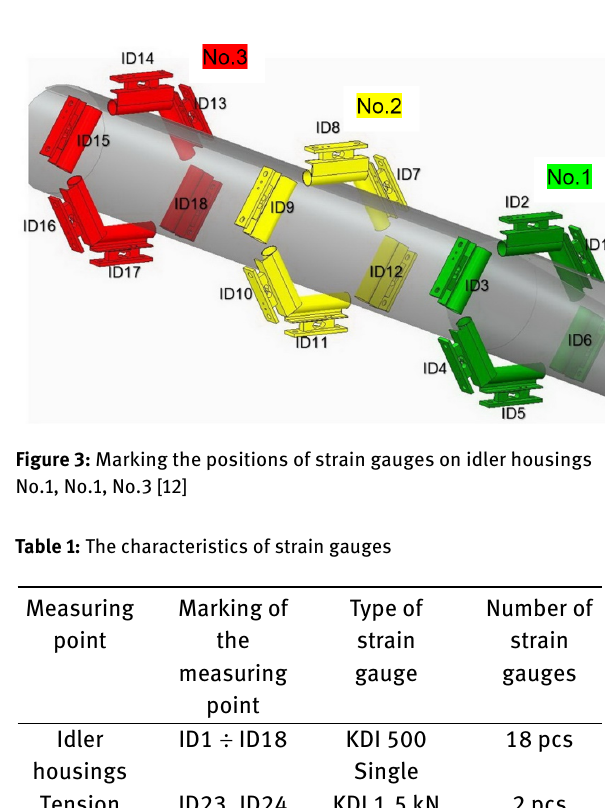
terial. Both models contain three identical hexagonal idler housings No.1, No.2,